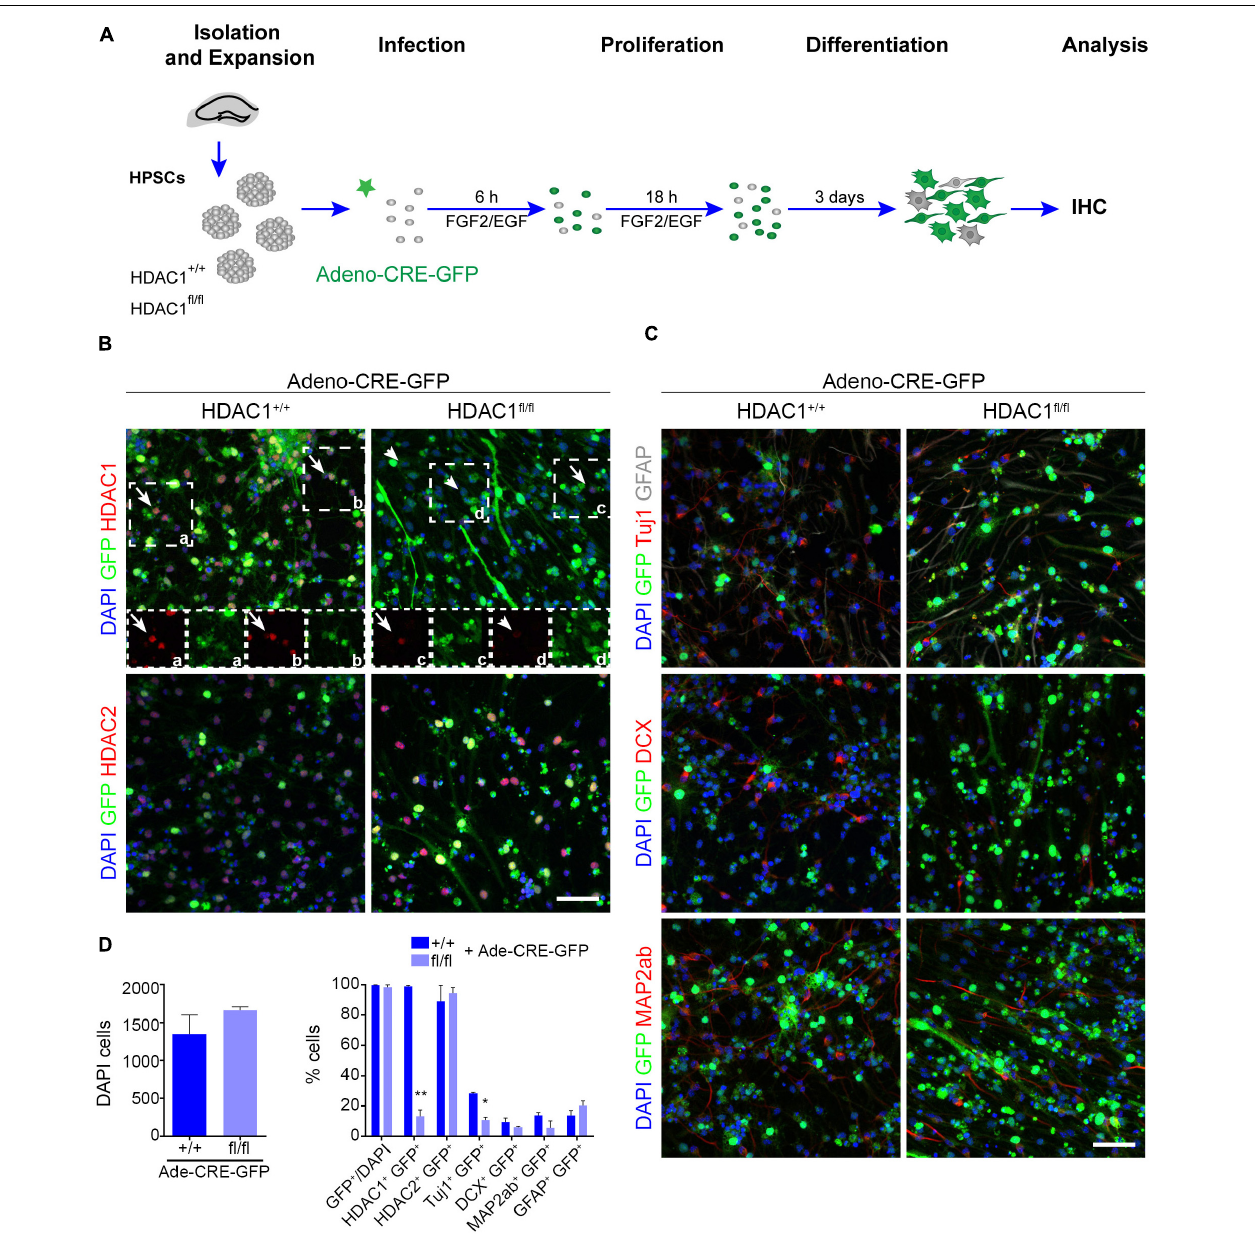
FIGURE 3 | HDAC1 affects HPSC differentiation in vitro . (A) Experimental design of expansion, infection and maintenance of HPSCs in differentiation condition. After infection cells were kept in differentiation condition (EGF and FGF2 were removed 24 h after infection) for 4 days. (B) Representative images of HDAC1 + / + and HDAC1 fl / fl HPSCs infected with adeno-Cre-virus immunostained against GFP, HDAC1, HDAC2, and stained with DAPI. (C) Representative images of HDAC1 + / + and HDAC1 fl / fl HPSCs infected with adeno-Cre-virus immunostained against GFP, Tuj1, GFAP, DCX and MAP2ab, and stained with DAPI. (D) The graphs show the number of DAPI cells in 10 random fields in HDAC1 + / + and HDAC1 fl / fl cells infected with an adeno-Cre-GFP virus and the percentage of GFP + cells out of the DAPI cells and the percentage of GFP + cells expressing HDAC1, HDAC2, Tuj1, DCX, MAP2ab, and GFAP. * p < 0.05, ** p < 0.01, ns = not significant. N = 2. Scale bar = 50.